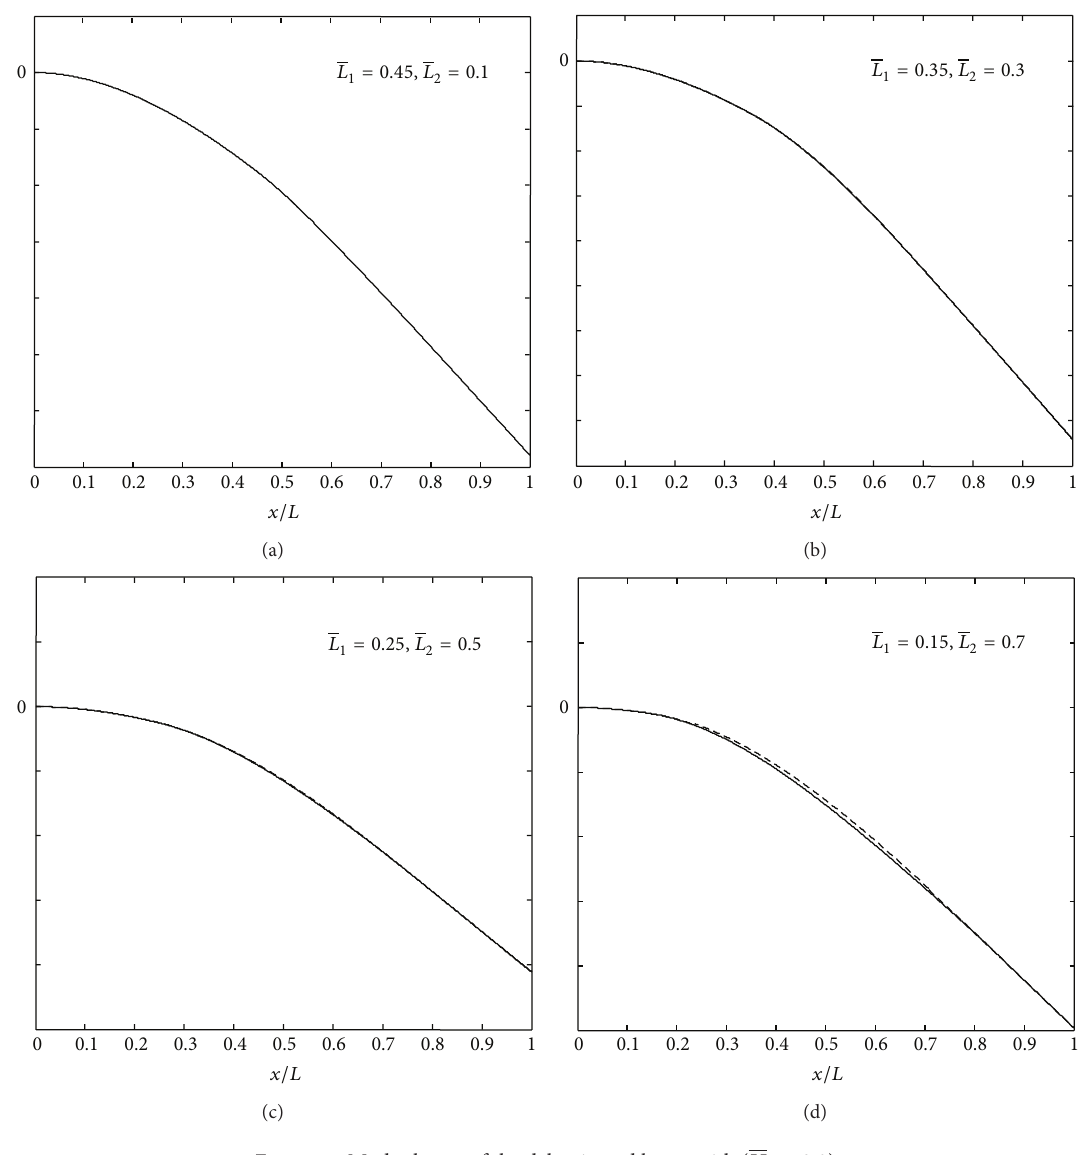
Figure 5: Mode shapes of the delaminated beam with ( 𝐻 2 = 0.3